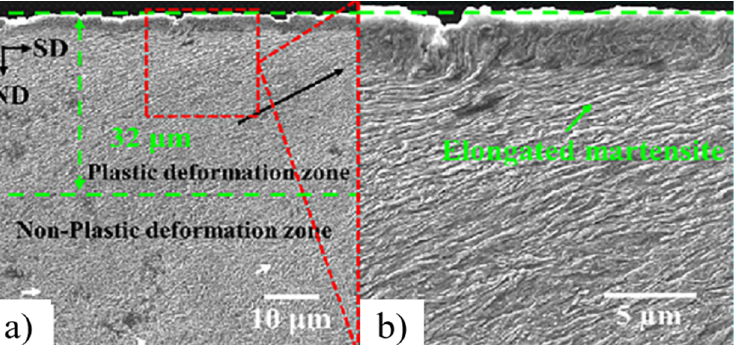
Figure 8. The microstructure of 300 M steel after UNSM treatment: ( a ) the SPD layer, ( b ) the tempered martensite in the SPD layer. Reprinted with permission from ref. [77]. Copyright 2019, Elsevier. Zhao et al. [86] explored the use of UNSM to improve the microstructure of